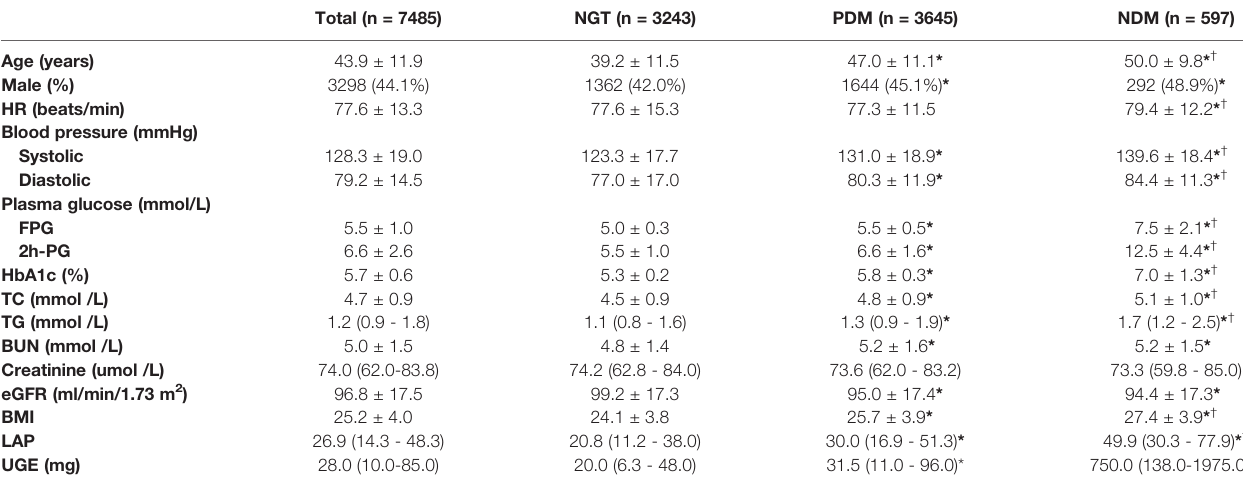
TABLE 1 | Characteristics of the study participants according to glucose tolerance